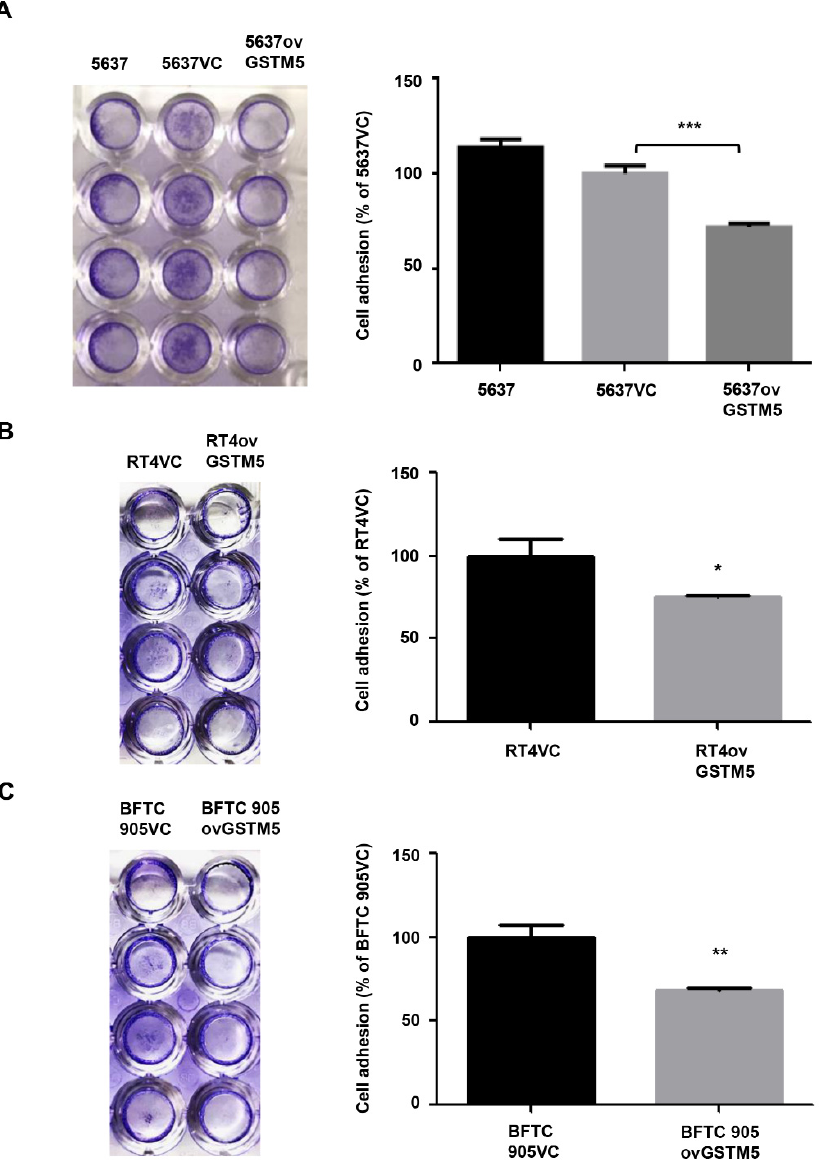
Figure 7. Cell adhesion analysis. ( A ) The adhesion capacity of 5637, ( B ) RT4, and ( C ) BFTC 905 cells. Each VC cell was set as 100%. The data are presented as the mean ± SE of three independent experiments. * p < 0.05, ** p < 0.01, *** p < 0.001.